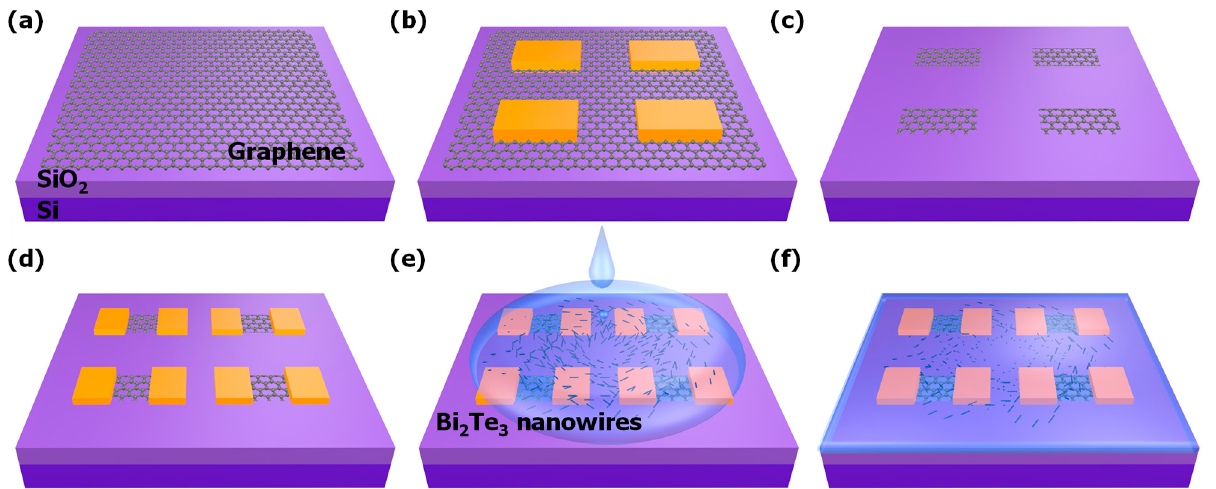
Figure 1. Schematic diagram of the Bi 2 Te 3 nanowires (NWs)/graphene photodetector fabrication process. ( a ) Graphene transfer on the SiO 2 /Si substrate, ( b ) graphene channel hard mask, ( c ) graphene channel patterning, ( d ) source and drain (S/D) electrode patterning, ( e ) Bi 2 Te 3 nanowires (NWs) drop casting on the device, and ( f ) annealing the fabricated device.